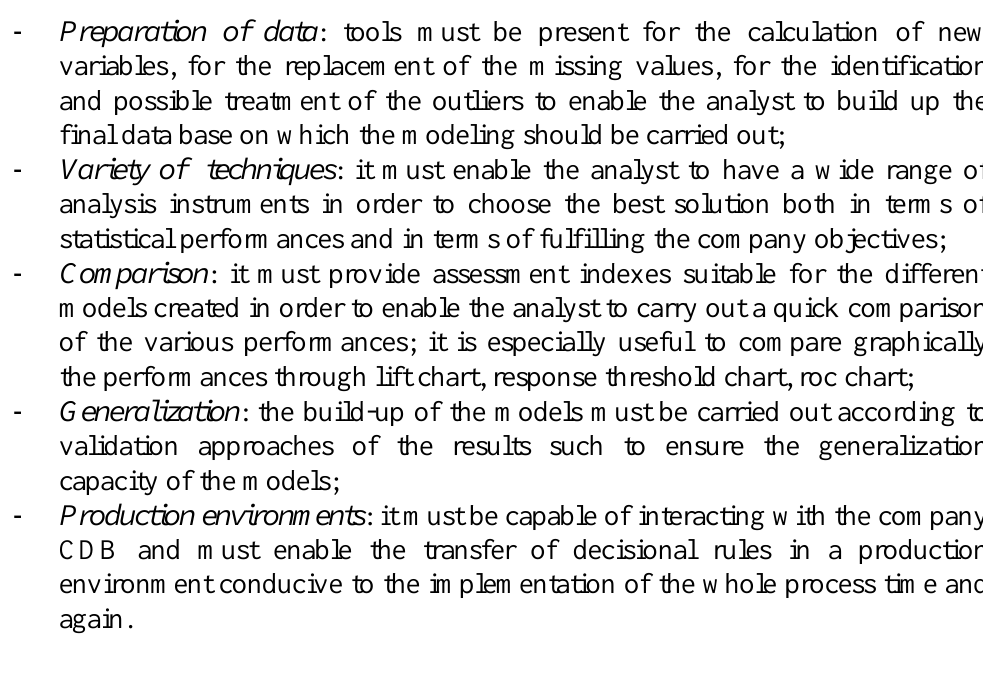
Figure 3: An Example: SAS Enterprise